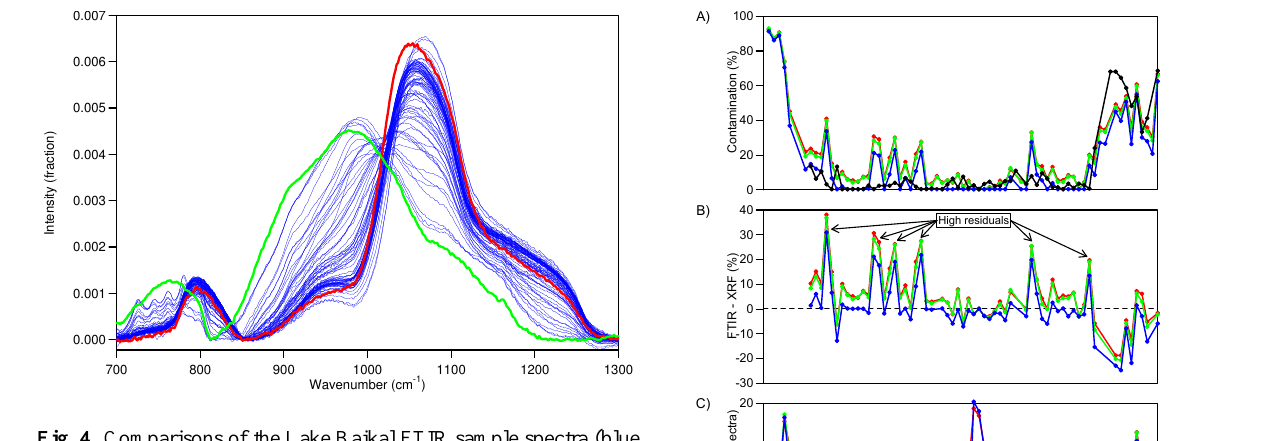
Fig. 4. Comparisons of the Lake Baikal FTIR sample spectra (blue lines) against the BFC mod (red line) and “Silt” (green line) spec- tra. Spectra of contaminated samples are either aligned to the “Silt” spectra or to a mixture of the diatom/“Silt” spectra.